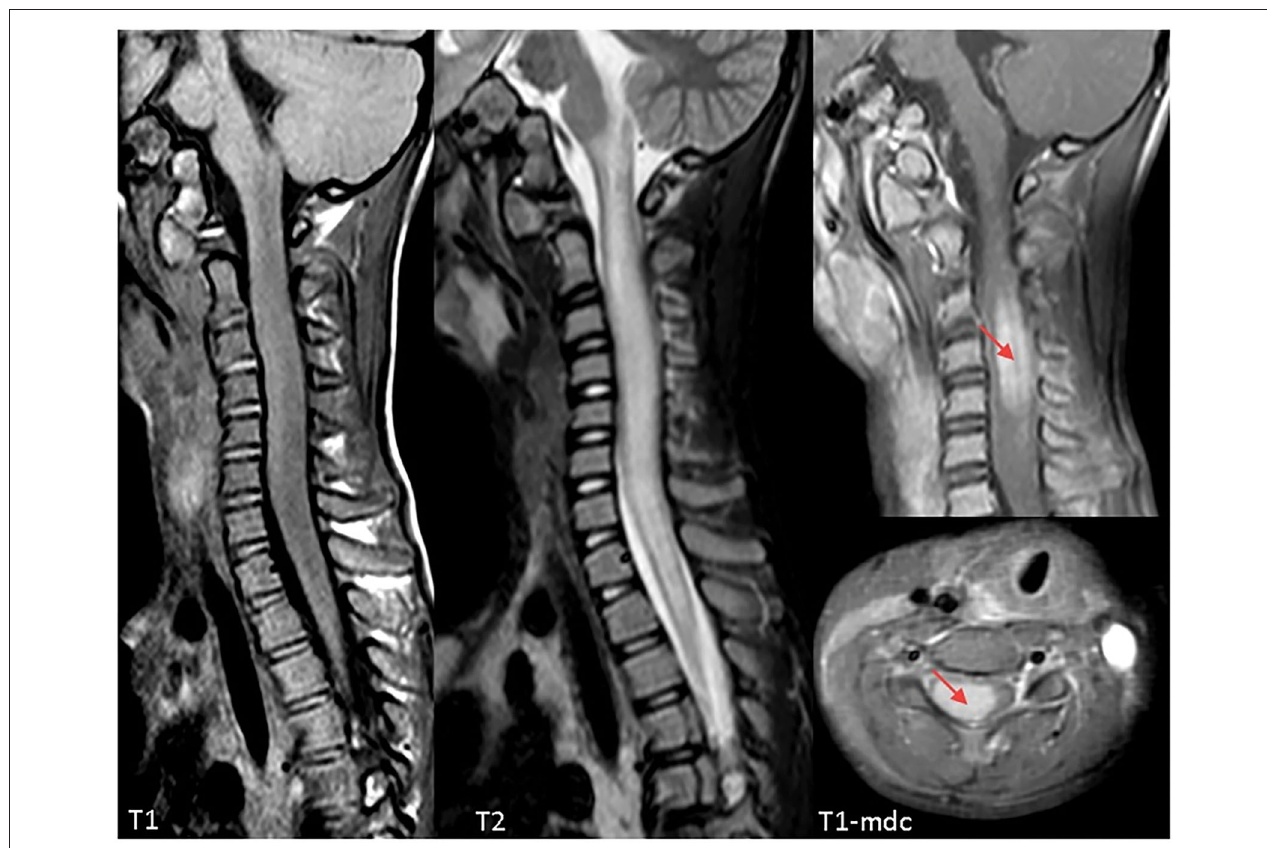
FIGURE 1 | Cervical Magnetic Resonance Imaging (MRI) at clinical onset demonstrating a longitudinally extensive signal abnormality involving the cervical spinal cord, extending from the obex to D3. The cord appears markedly swollen, both gray and white matter are involved, and post-contrast sequences demonstrate marked cord enhancement between C3 and C5 (red arrows). Findings are compatible with acute longitudinally extensive transverse myelitis (LETM).